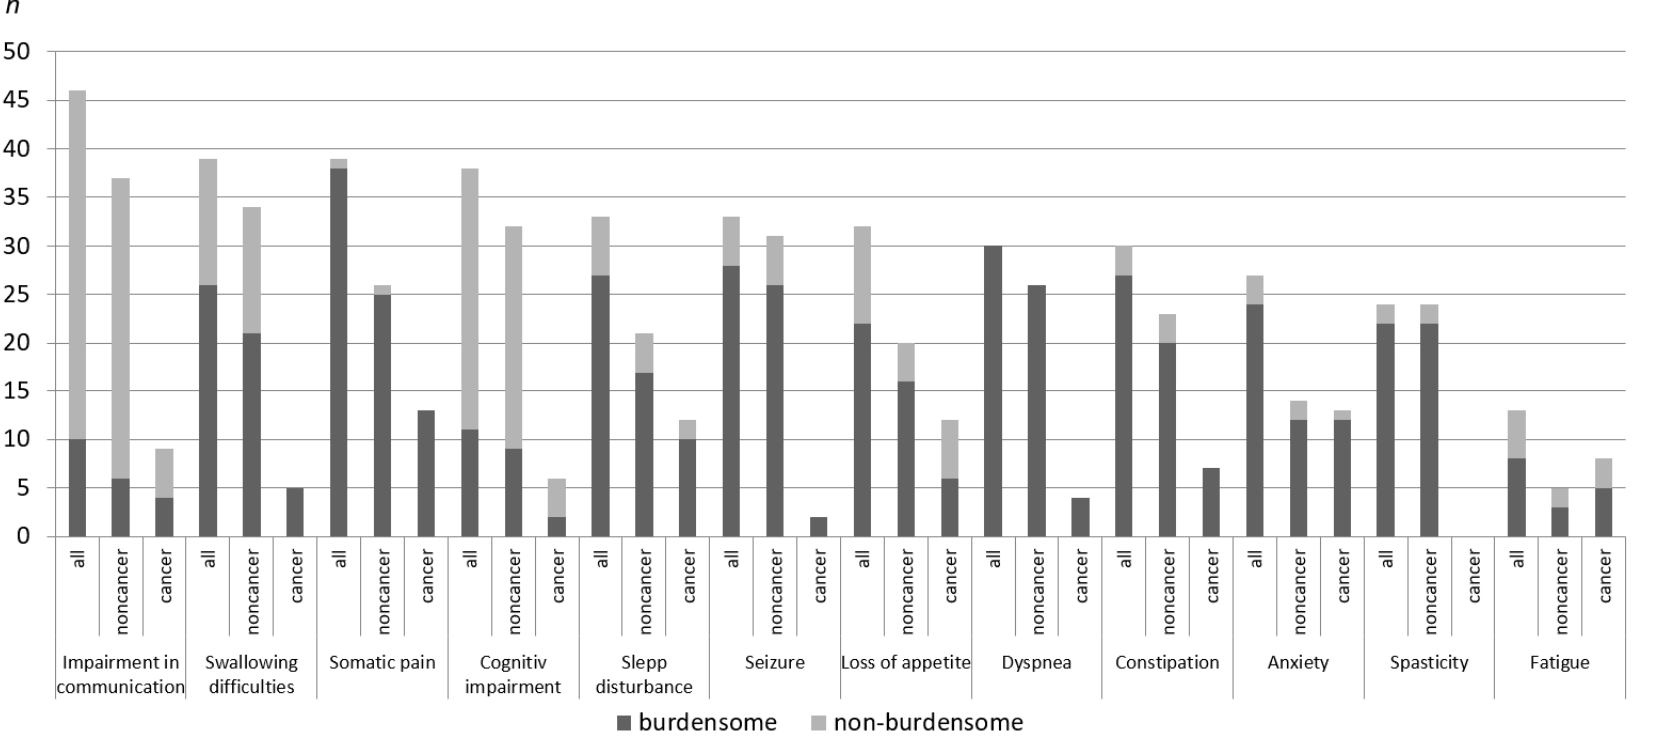
Figure 2. Symptom burden in patients with cancer and non-cancer condition.